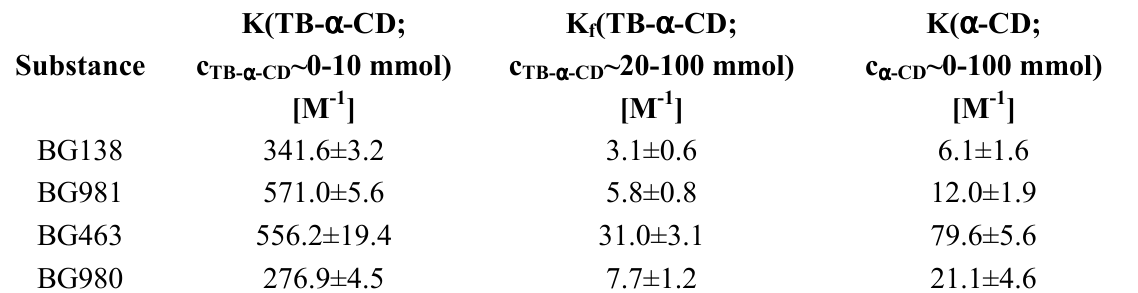
Table 2 . Association constants for 1:1 inclusion complexation of 9-alkylthioacridine derivatives with TB- α -CD and α